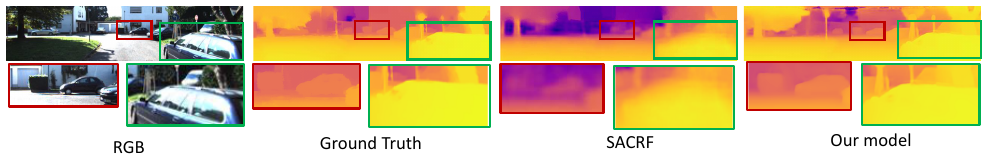
Figure 1. In scenes with significant variations in depth, the multi-scale depth estimation technique SACRF [35] cannot adequately predict individual background/foreground depth maps, whereas our model could improve individual foreground and background depth map prediction using an attention mechanism and image